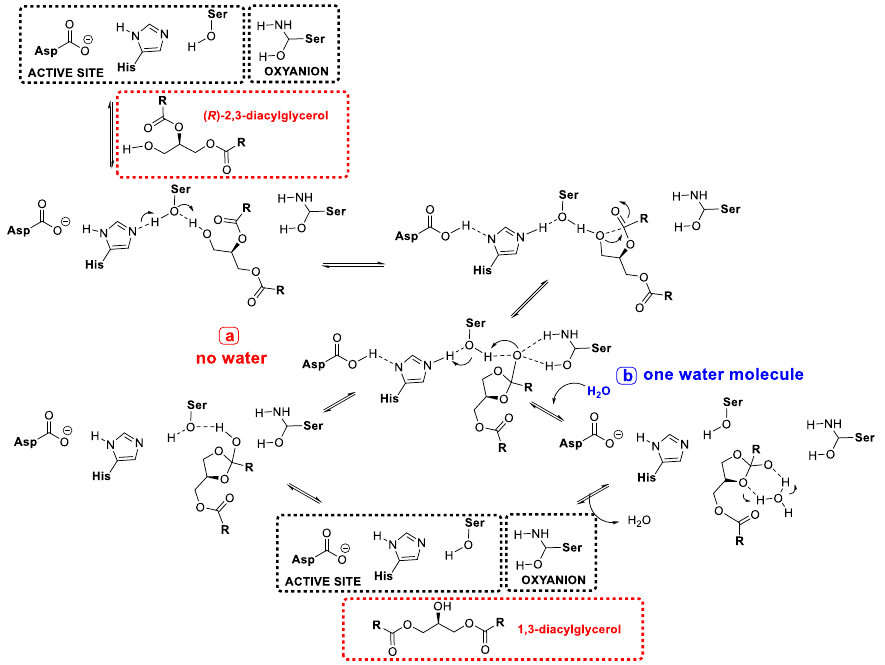
Figure 12. Postulated mechanisms of acyl migration in the lipase-catalyzed mechanism (LCM) scheme: ( a ) without and ( b ) with the aid of water (adapted from Mao et al. [214]).